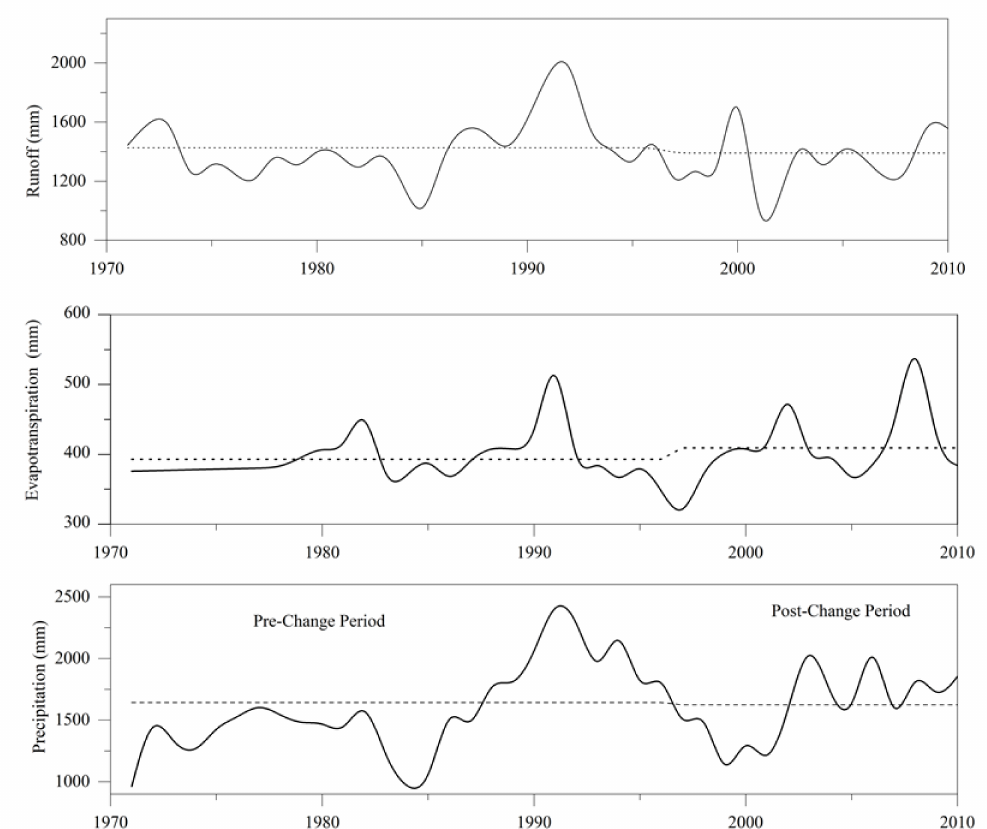
Figure 9. Temporal variation in precipitation, evapotranspiration, and runoff over the KRB.